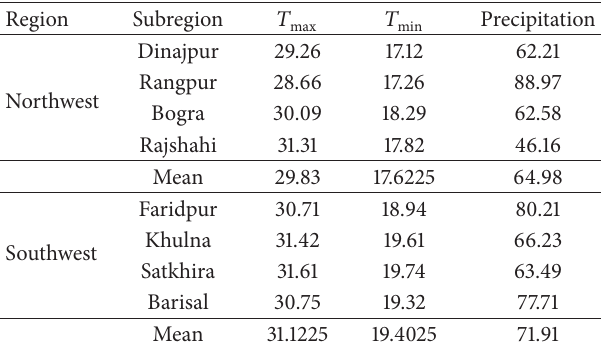
Table 1: The variations in climatic parameters during the winter Boro paddy growing season (1984–2013) in western Bangladesh. Region Subregion 𝑇 max 𝑇